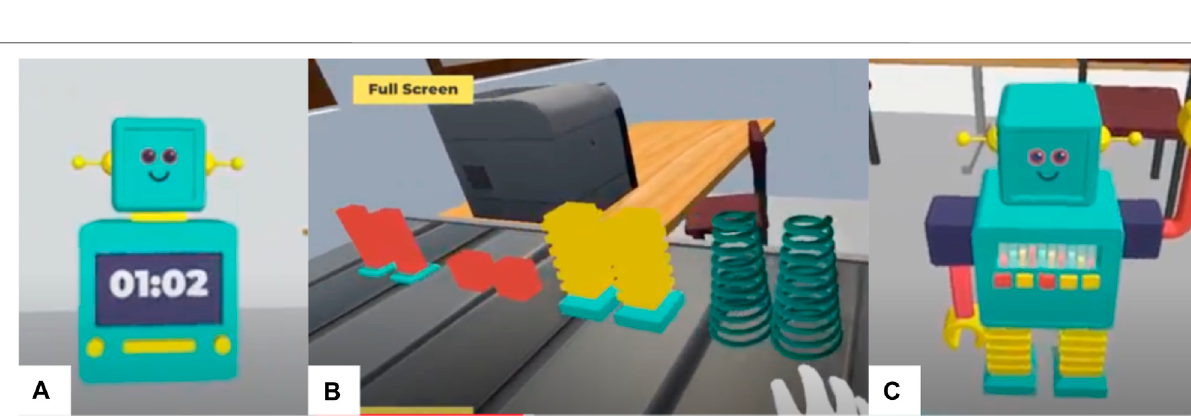
Frontiers in Virtual Reality |